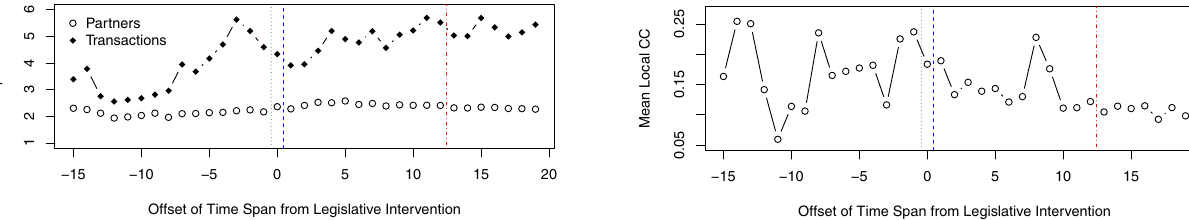
Fig. 6 Mean local clustering coef fi cient. Temporal representation of the mean local clustering coef fi cient for 30-day spans. The mean is moderate and decreases with time. Users are connected only with macro-agents and are less focused on each other.